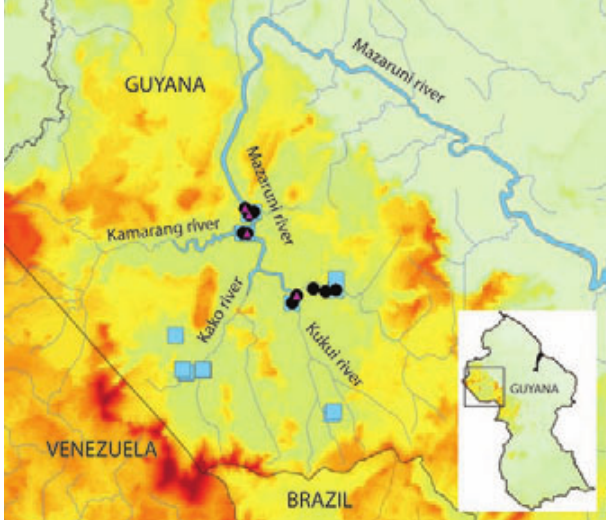
Fig. 7. Map of the upper Mazaruni River basin showing collection localities and known distribution of the three species of Mazarunia . Blue squares: Mazarunia charadrica , Black circles: Mazarunia mazarunii ; Purple triangles: Mazarunia pala . One symbol may represent more than one collection